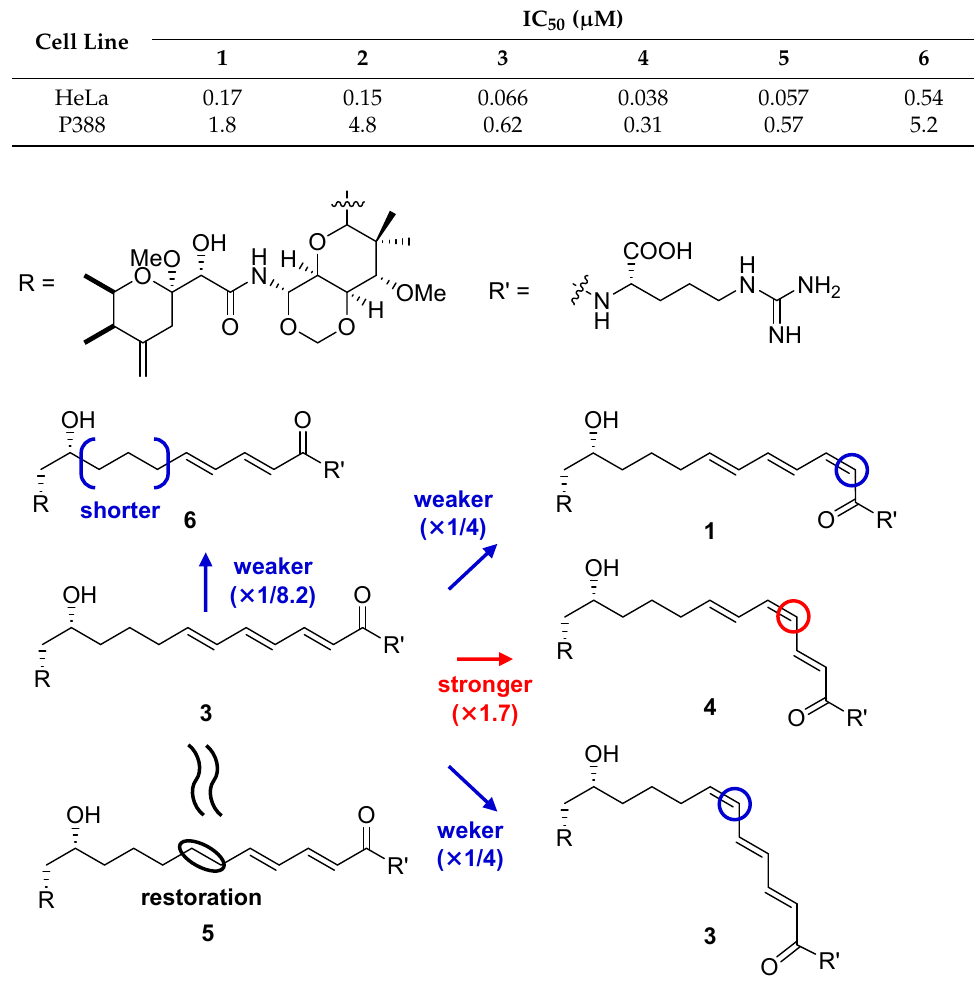
Figure 3. SARs of compounds 1 – 6 on the cytotoxicity against HeLa cells.